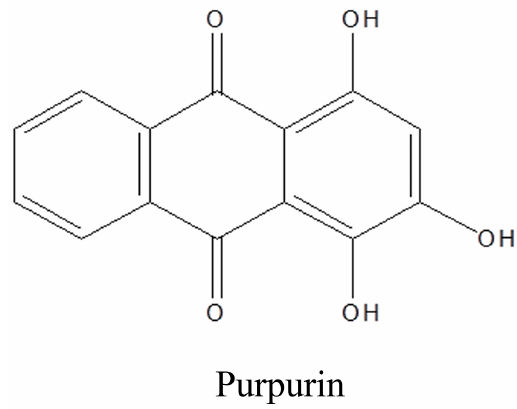
Figure 1. The chemical structure of purpurin.